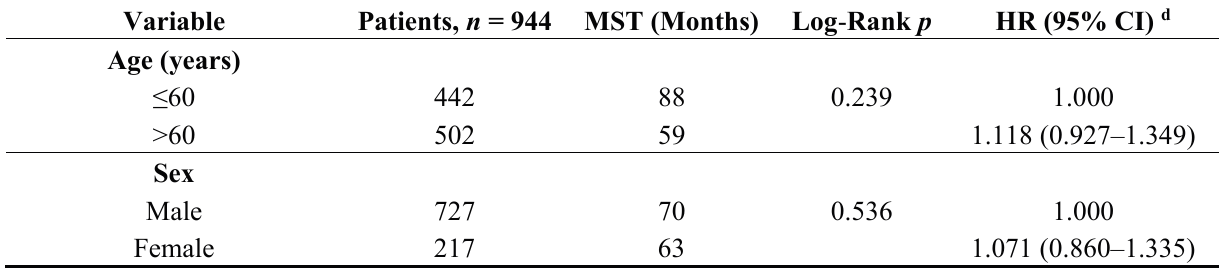
Table 1. Associations between clinicopathological variables and overall